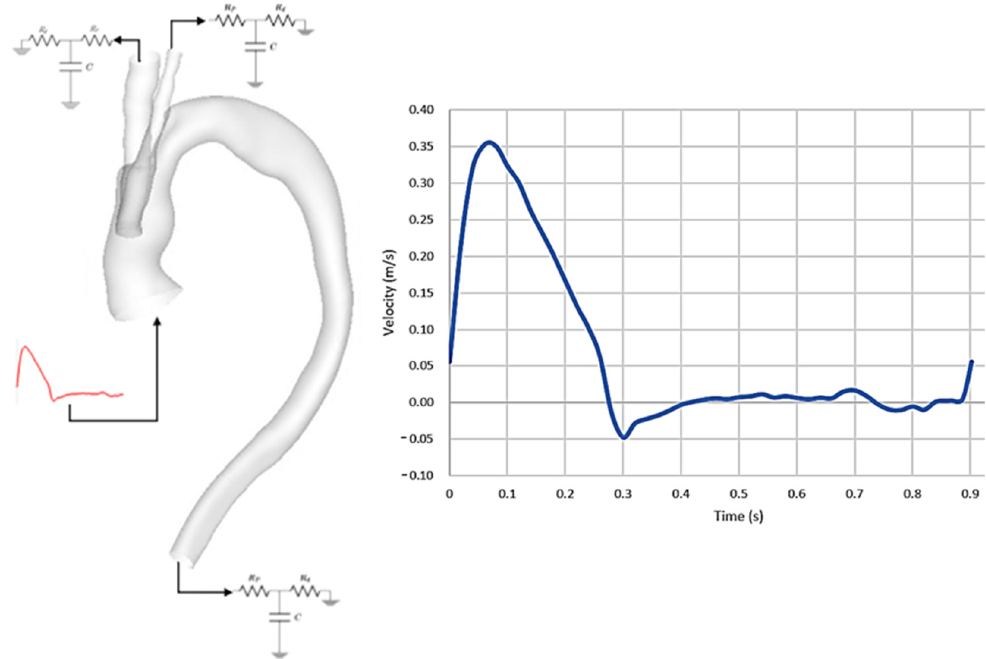
Figure 2. ( Left ) Representation of reconstructed 3D geometry showing prescribed boundary condi- tions, with inflow waveform imposed at the model inlet and 3 − EWM prescribed at the three model outlets. ( Right ) Pulsatile velocity waveform prescribed at the inlet.